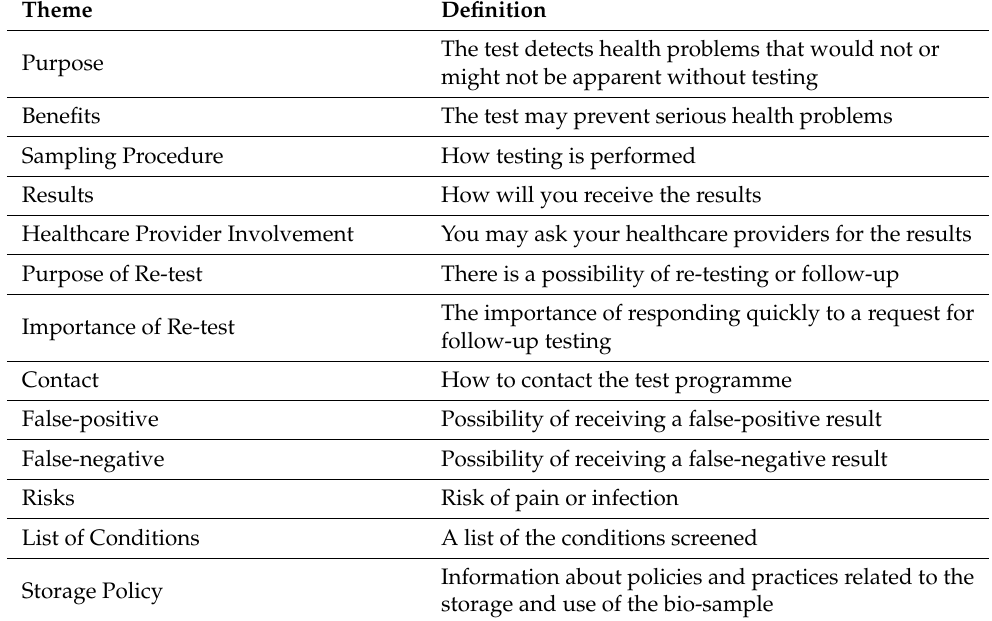
Table 1. Fundamental Messages Recommended by